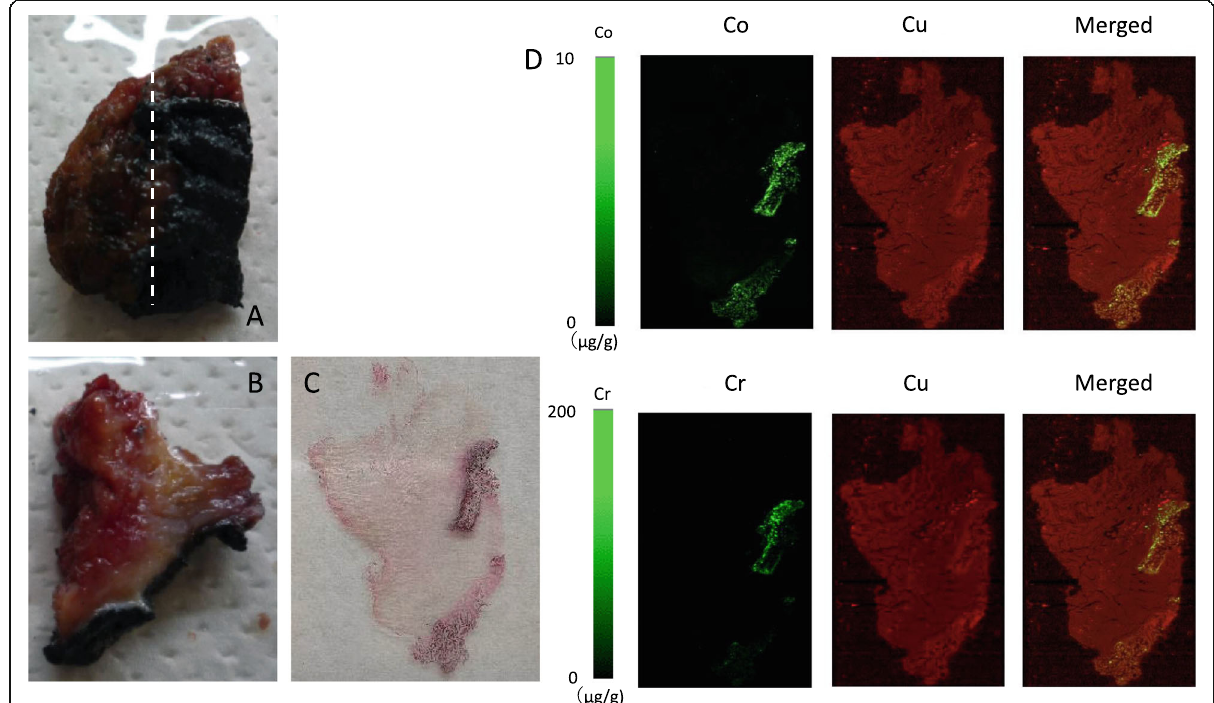
Fig. 6 Photographs of extracted specimens and distribution of cobalt or chromium in the joint capsule. A Anterior capsule. White dotted line shows the slice levels in panels B – D. B Slice of the anterior capsule. C Serial section from tissue in B (hematoxylin-eosin, × 40). D Semi- quantitative laser ablation-inductively coupled plasma mass spectrometry images. Left panels: quantitative images of cobalt or chromium. Middle panels: images of copper distribution inside the joint capsule as a position reference. Right panels: merged images of cobalt or chromium and copper